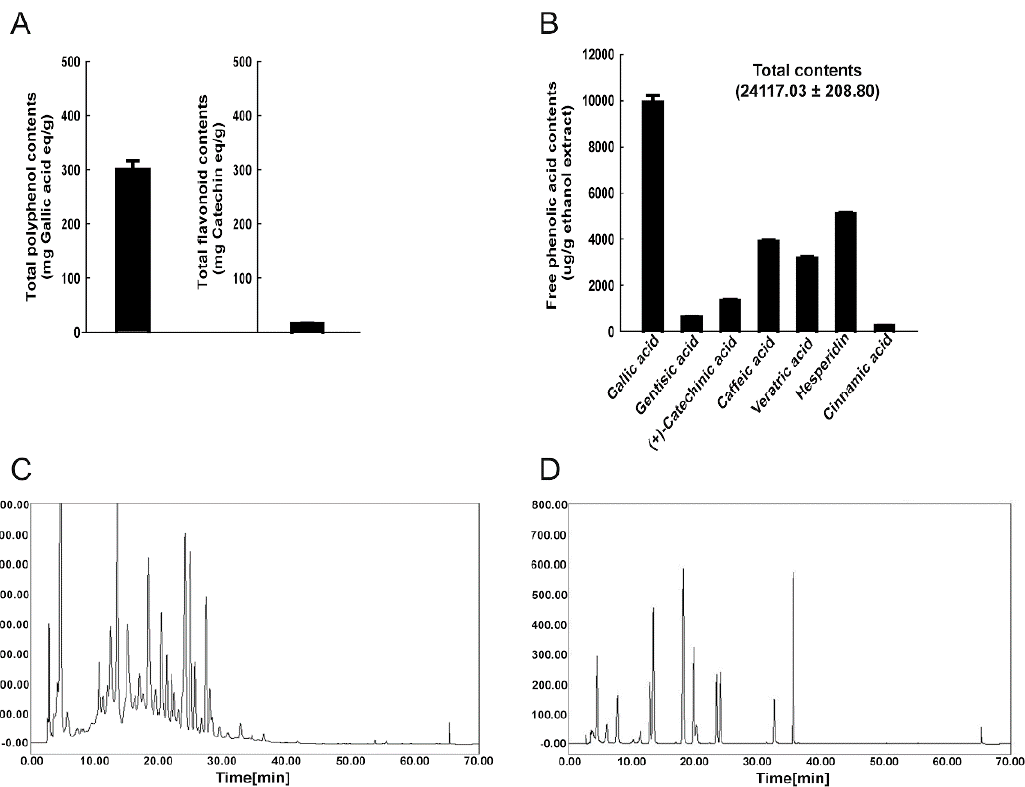
Figure 1. Polyphenol and flavonoid contents in white rose petal extract (WRPE). ( A ) Total amounts of phenol (gallic acid equivalent/g extract) and flavonoid (catechin equivalent/g extract) compounds. ( B ) Free phenolic acid contents in WRPE identified by HPLC. ( C ) HPLC chromatograms of WRPE. Peaks were analyzed based on HPLC chromatograms of phenolic acid standards. ( D ) HPLC chromatograms of phenolic acid standards.